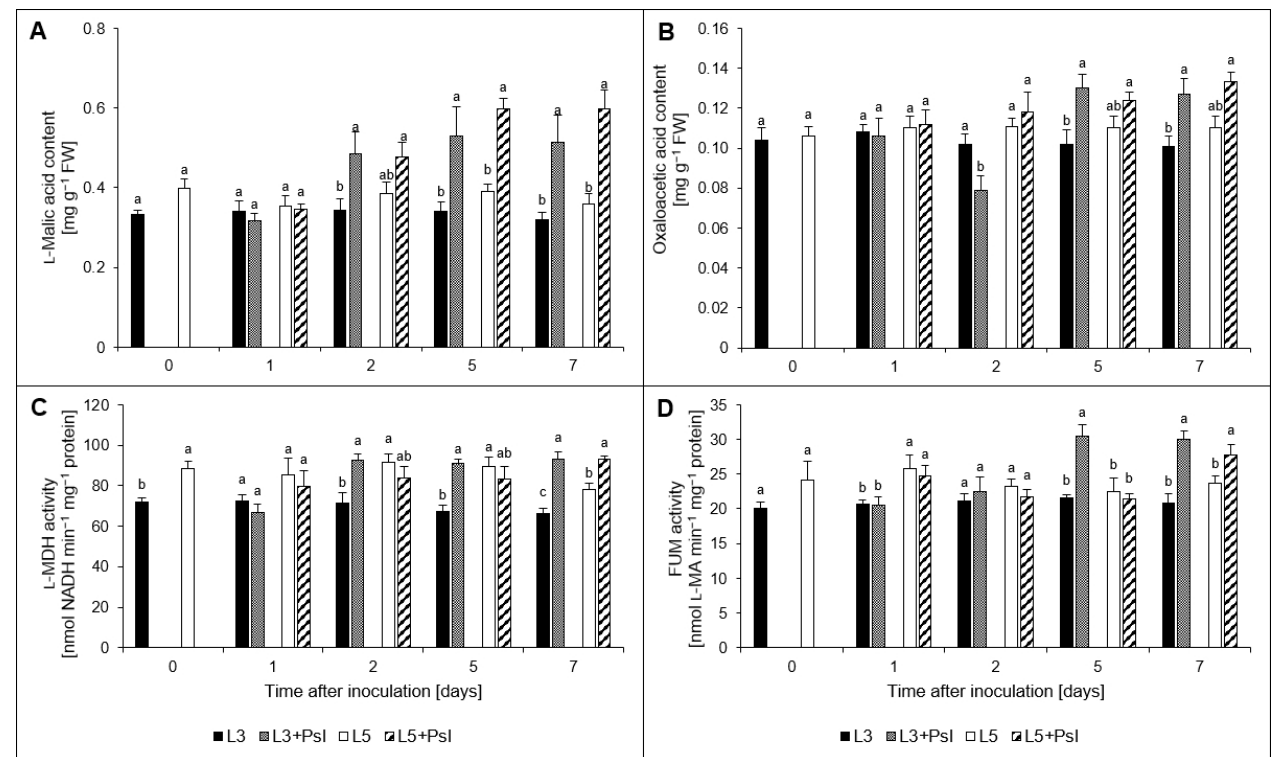
Figure 5. Changes in ( A ) L -malic acid content, ( B ) oxaloacetic acid content, ( C ) L -malic acid dehydrogenase ( L -MDH) activity, and ( D ) fumarase (FUM) activity in cucumber leaves after P. syringae pv lachrymans infection. Values are means of four replicates (±SD). Different letters (a–c) indicate significant ( p ≤ 0.05) differences between experimental variants at a given time point.